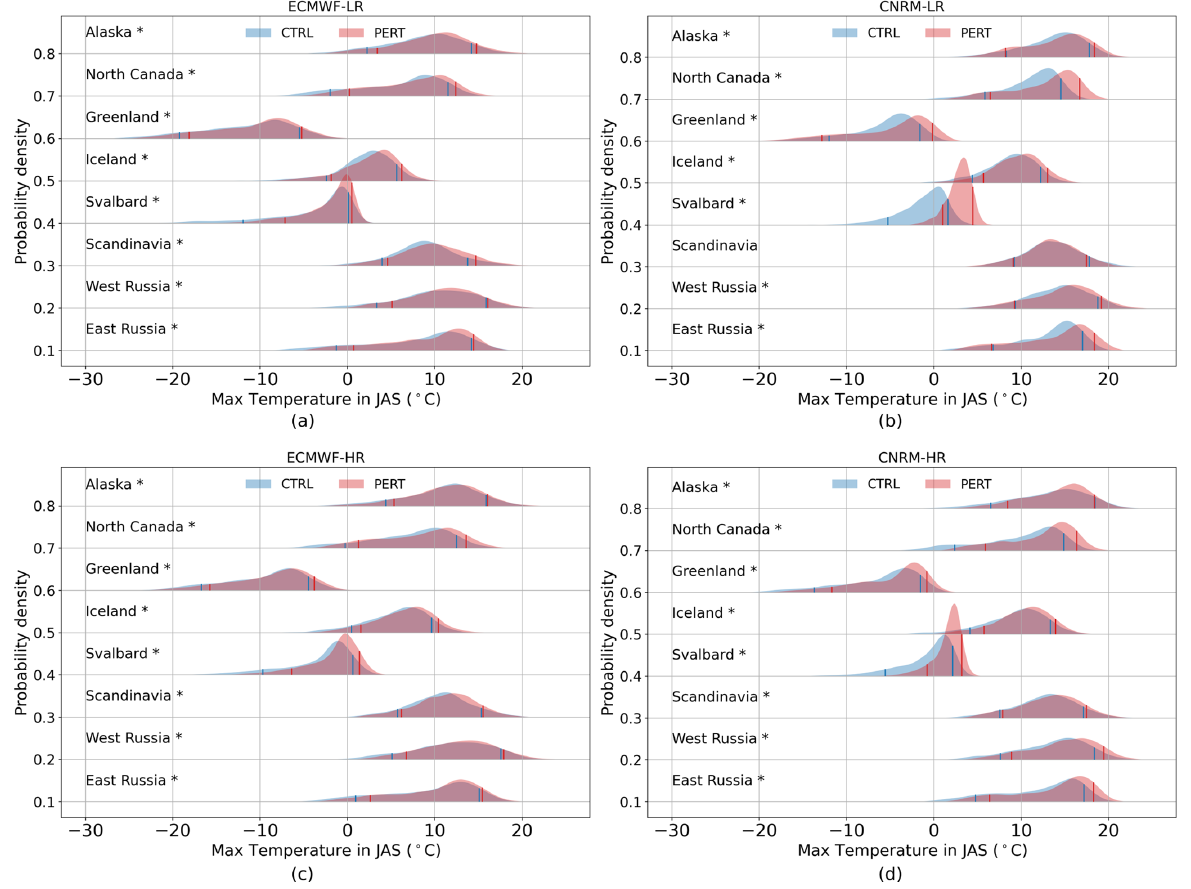
Figure 6. Probability density function (PDF) of the daily maximum surface air temperature ( ◦ C − 1 ) in summer (JAS) for ECMWF-LR (a) , CNRM-LR (b) , ECMWF-HR (c) and CNRM-HR (d) . PDF of the CTRL is the blue distribution, and PDF of the PERT is the red distribution. The left blue (red) line and the right blue (red) line correspond to the 10th percentile and 90th percentile of the CTRL (PERT), respectively. A star next to the name of the region shows if the distribution change is statistically significant according to a 5% level Kolmogorov–Smirnov test. An offset on the y axis of 0.1 is taken into account for each region.